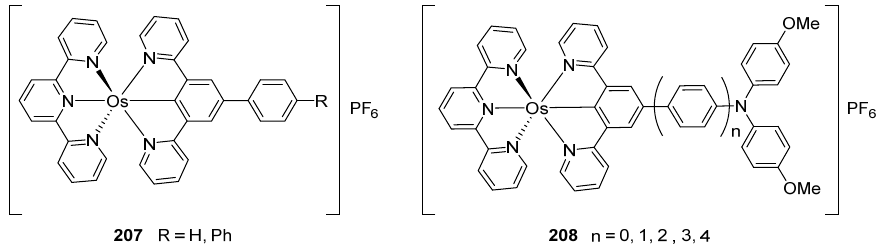
Figure 52. Bis -tridentate cyclometalated osmium complexes studied as molecular wires.